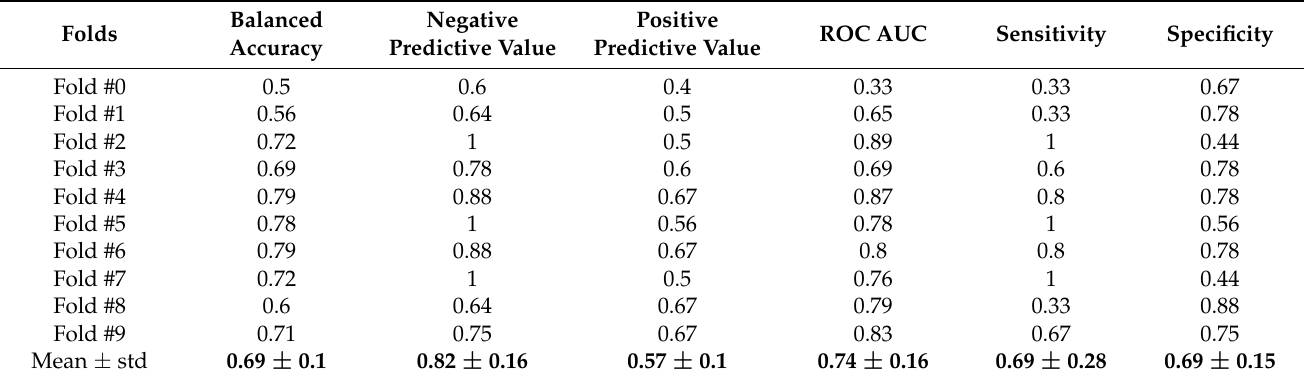
Figure 3. Normalized Confusion Matrix regarding the Gradient Boosting Classification algorithm for the CAD risk prediction using imaging and non-imaging data. The percentage of the true negative predicted cases is 73%, whereas the percentage of the true positives cases is 87%. Table 4. Evaluation of the CAD risk-prediction problem over 10-fold using only non-imaging data (AUC, area under